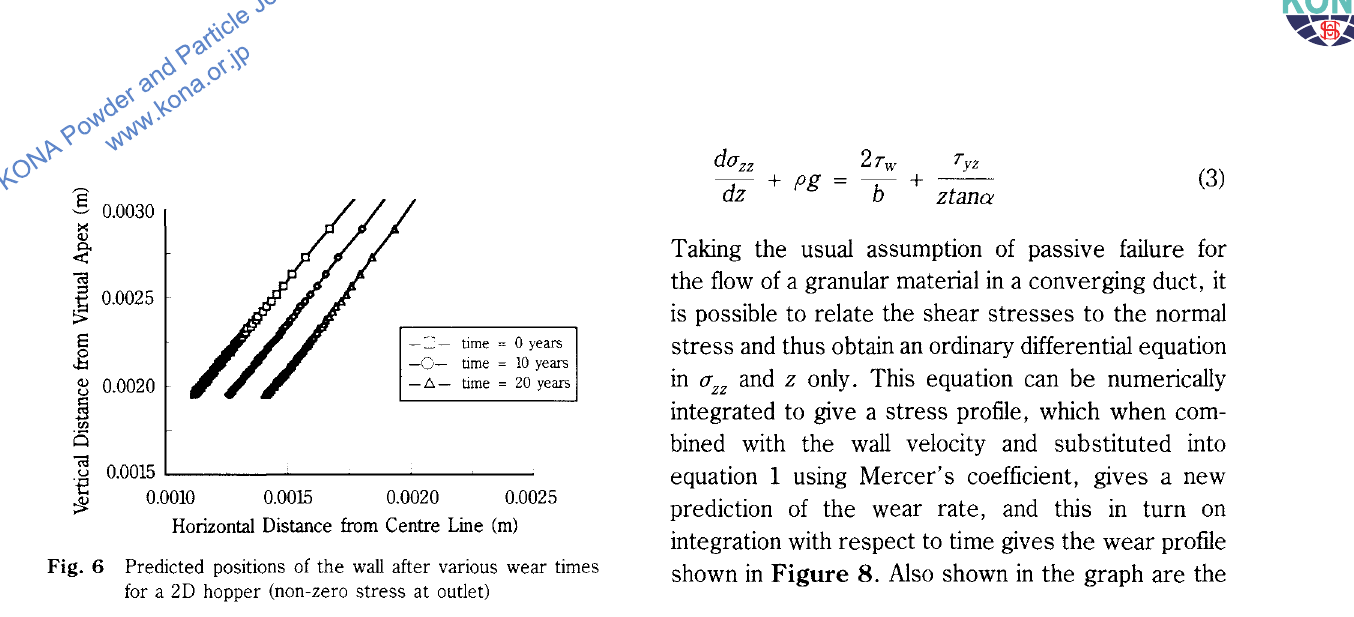
Fig. 6 Predicted positions of the wall after various wear times for a 20 hopper (non-zero stress at outlet) 5.